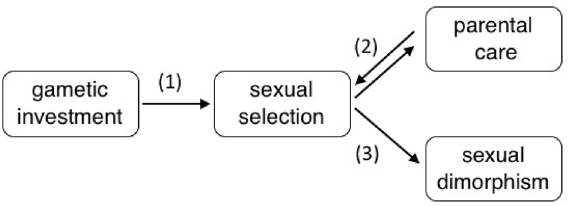
Figure 1. Schematic illustration of the Darwin–Bateman paradigm based on Janicke et al. 23 . The bias in gametic investment between males and females is assumed to lead to different reproductive rates of males and females, and hence to intense sexual selection among males (pathway 1), female-biased parenting (pathway 2), and elaborated trait expression in males (pathway 3). The figure was created using Keynote https:// www. apple. com/ uk/ keyno